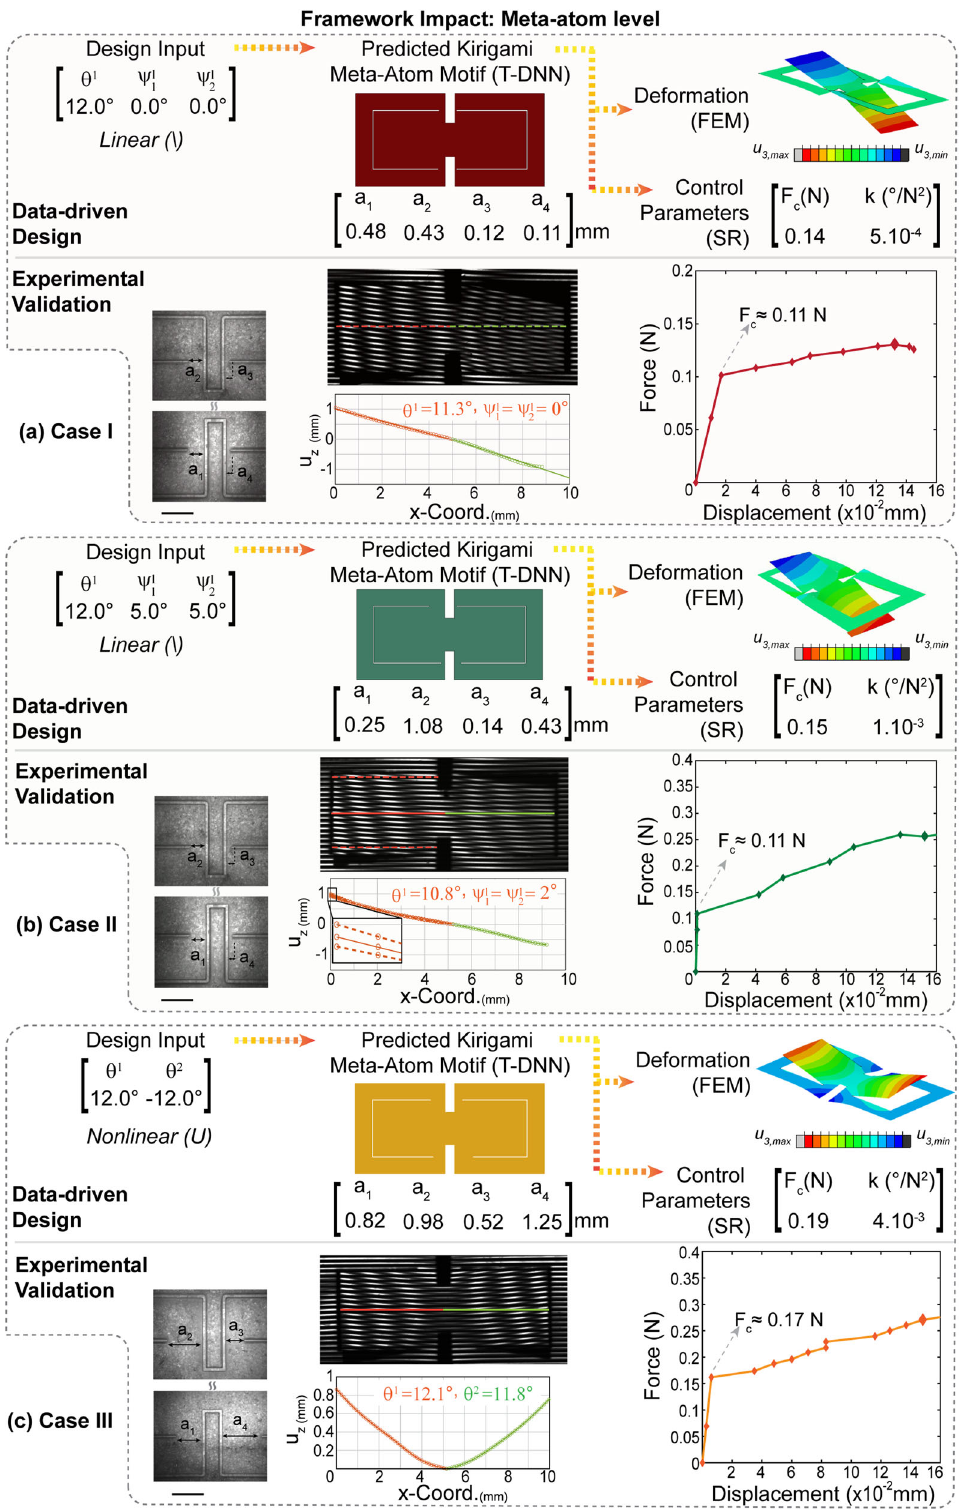
Fig. 6 Inverse design framework application and experimental validation at the meta-atom level. a Design case I (Linear kirigami without twist). b Design case II (linear kirigami with a twist). c Design case III (nonlinear kirigami). Scale bar = 1